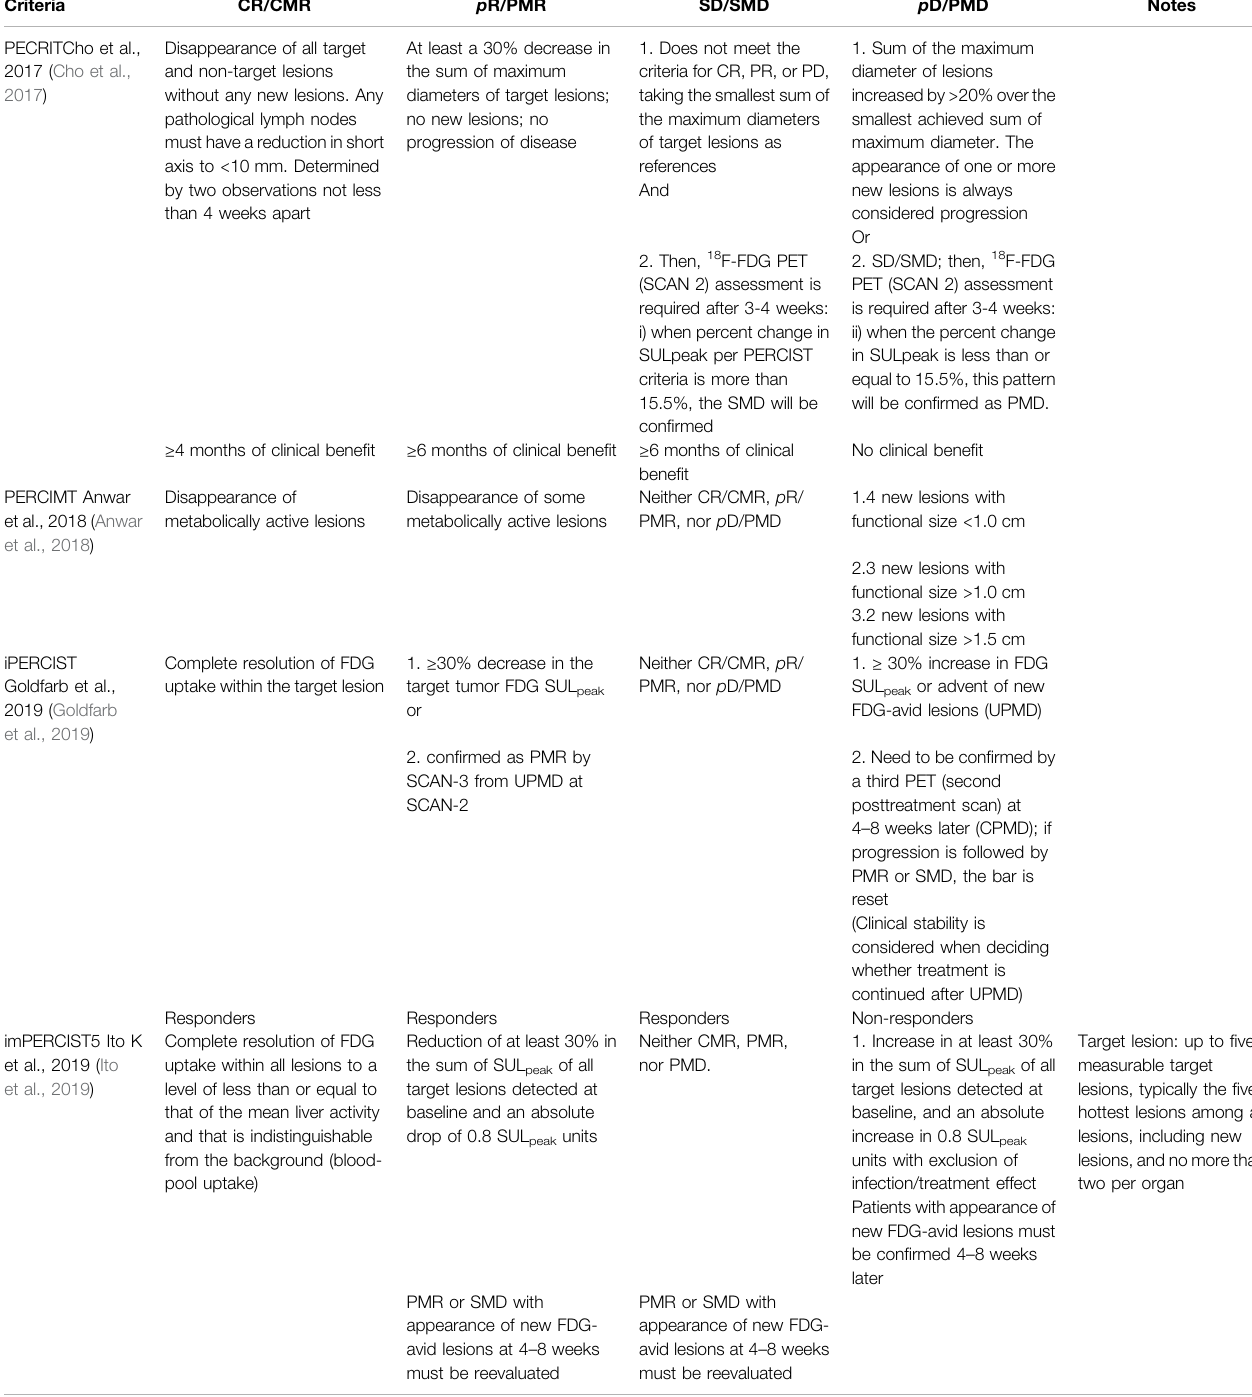
TABLE 3 | 18 F-FDG PET/CT assessing criteria for